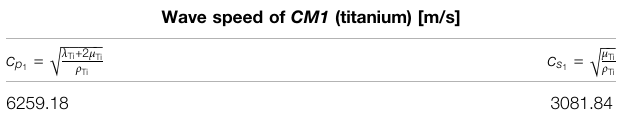
TABLE 5 | Wave speed expressions for the Cauchy material CM1 . Wave speed of CM1 (titanium)